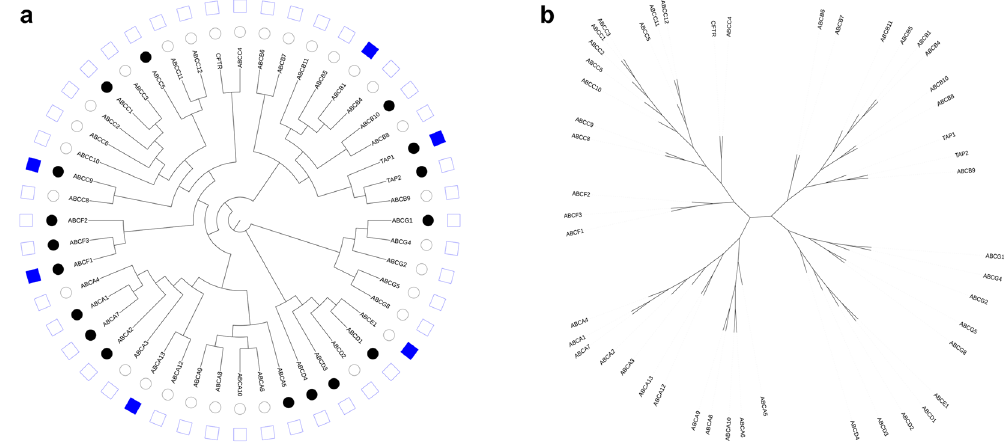
Figure 2. Subsets of ABC transporter proteins are expressed but not regulated in primary human neutrophils. Scalable phylogenetic trees in both ( a ) circular and ( b ) unrooted display modes indicate evolutionary relationships between ABC transporter proteins in humans (branch lengths are not proportional to genetic distance; see Supplementary Fig. S2 for trees with proportional branch lengths). In ( a ), for primary human neutrophil expression data (inner circle), expressed proteins are marked with a black dot, whereas proteins not expressed are denoted with a white dot. For human neutrophil proteomics data (outer circle), any proteins identified in one or more of the analyses are denoted with a blue box, and any not identified are denoted with a white